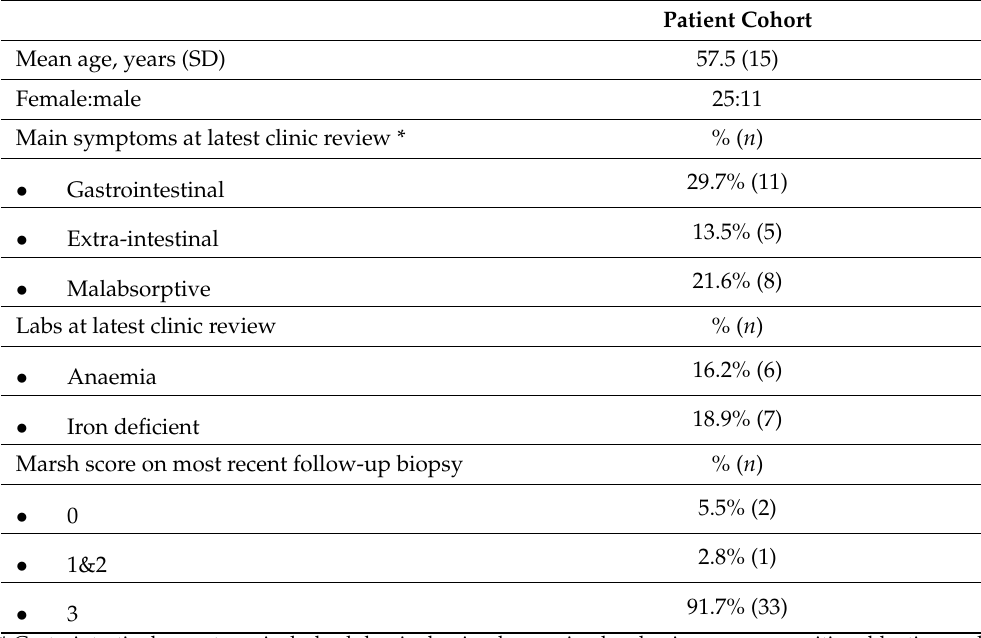
Table 3. Clinical and demographic details of patients diagnosed with RCD1 who underwent urinary GIP testing.